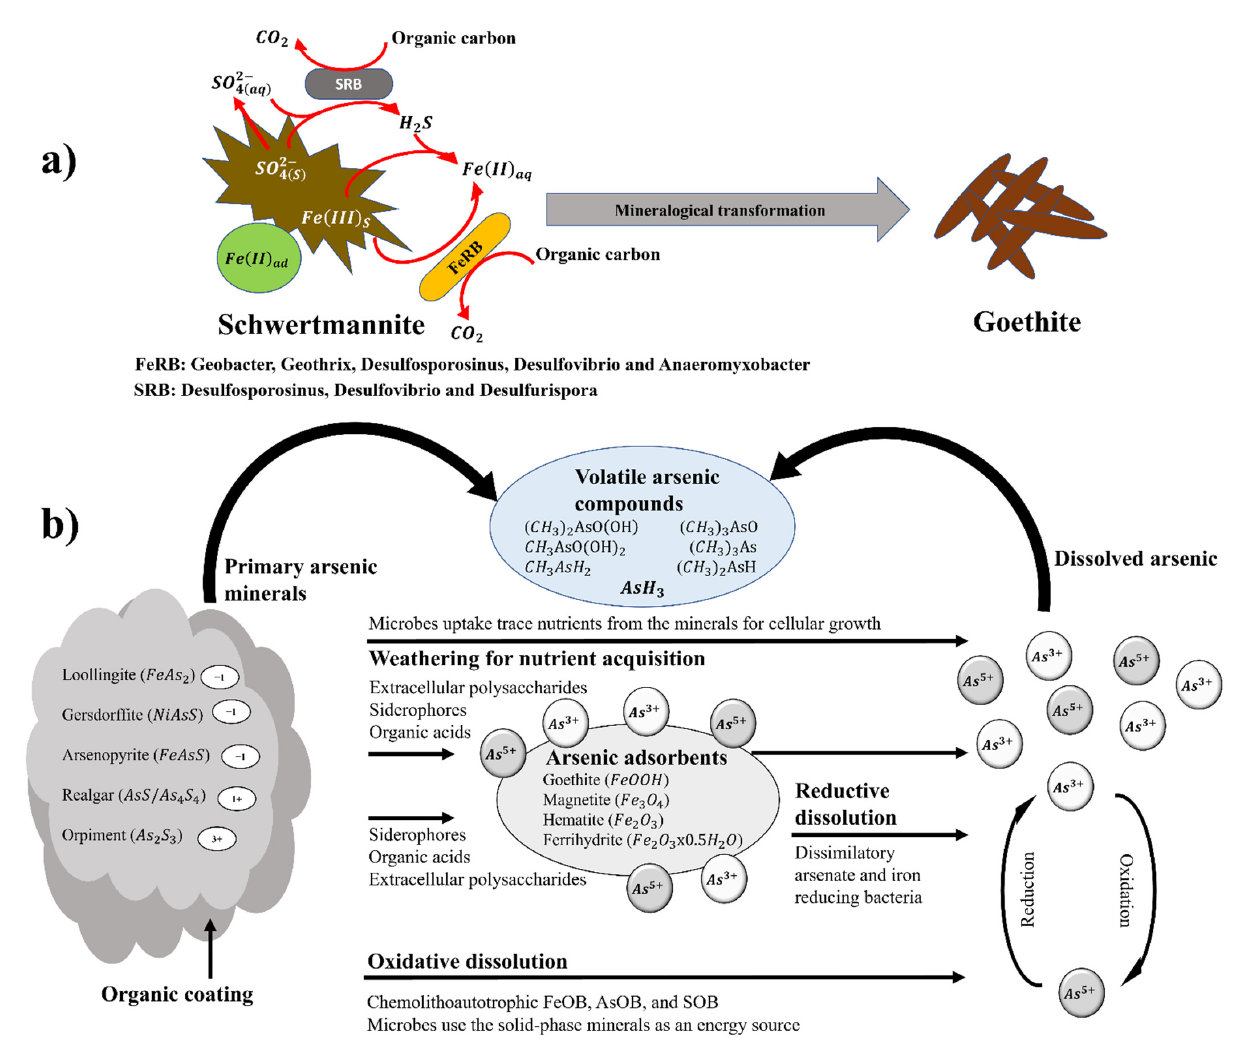
Figure 5. ( a ) Role of microorganisms in the transformation of schwertmannite to goethite. SRB: sulfur-reducing microorganisms; FeRB: iron-reducing microorganisms. Image adapted with permission from [169], published by Elsevier B.V., 2018; ( b ) Role of microorganisms in the mobilization of arsenic in mining environments. FeOB: iron-oxidizing microorganisms; AsOB: arsenic-oxidizing microorganisms; and SOB: sulfur-oxidizing microorganisms. Image adapted from [196].